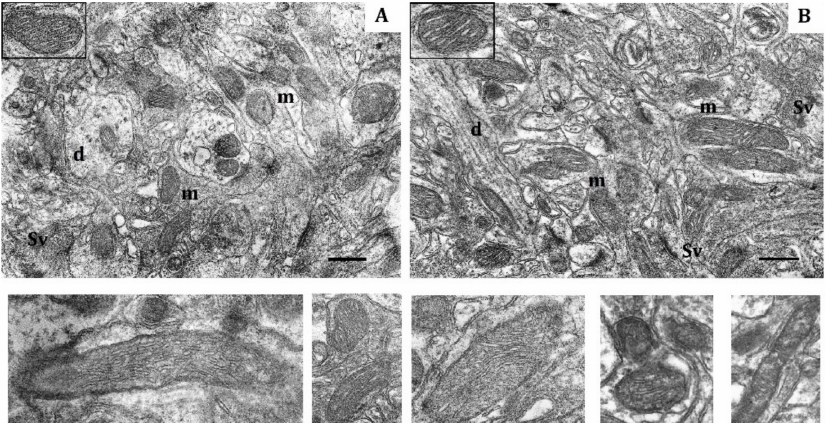
Figure 3. Effects of long-term hypobaric hypoxia (HBH-14% O 2 ) on the rat cerebral cortex in electron micrography. ( A ) rats with low-resistance to hypoxia; ( B ) rats with high-resistance to hypoxia. Scale bar: 0.5 µ m. For other designations, see legends to Figure